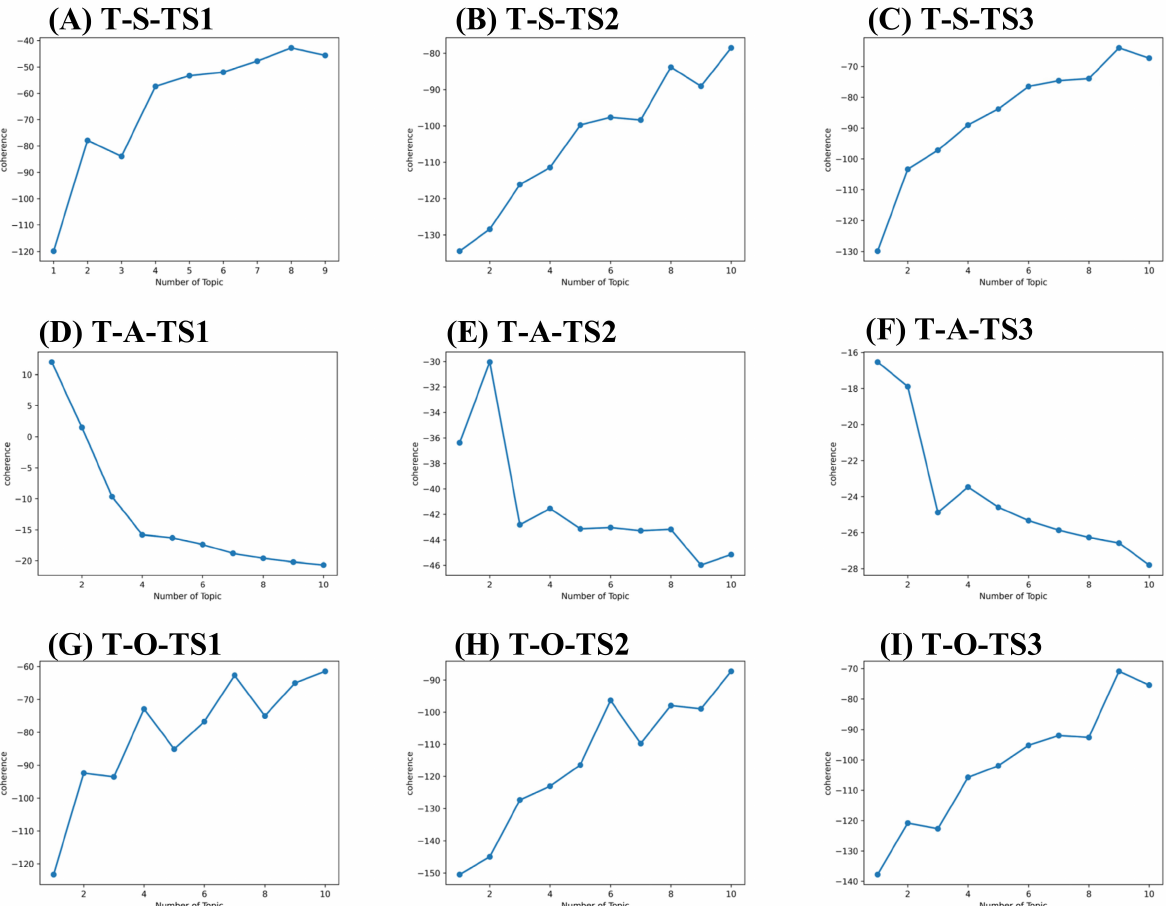
Figure 5. Topic coherence curve for technology layer. ( A ) Topic coherence value of S components